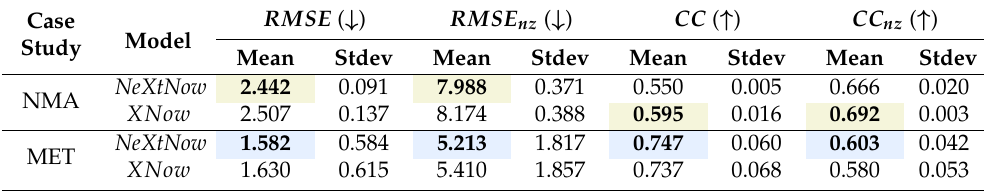
Table 6. The results for the regression metrics for the NeXtNow and XNow models, which were trained using one previous time step ( k = 1) for predicting one time step in the future using both the NMA and MET datasets. The means and standard deviations that were computed across the three experimental runs are shown. The best values for the performance metrics are marked with bold and colored with yellow (for the NMA case study) and with blue (for the MET case study).